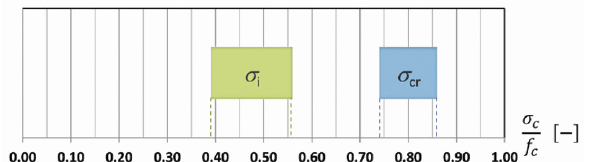
Fig. 9. Initiating stress σ i and critical stress σ cr intervals in high- performance concretes under compression